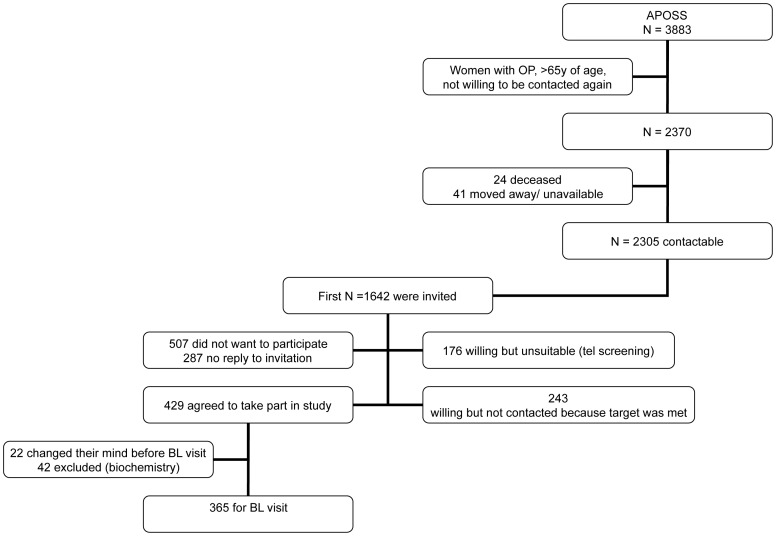
Study Flow Diagram.(APOSS: Aberdeen Prospective Osteoporosis Study, OP: Osteoporosis, BL: Baseline visit).